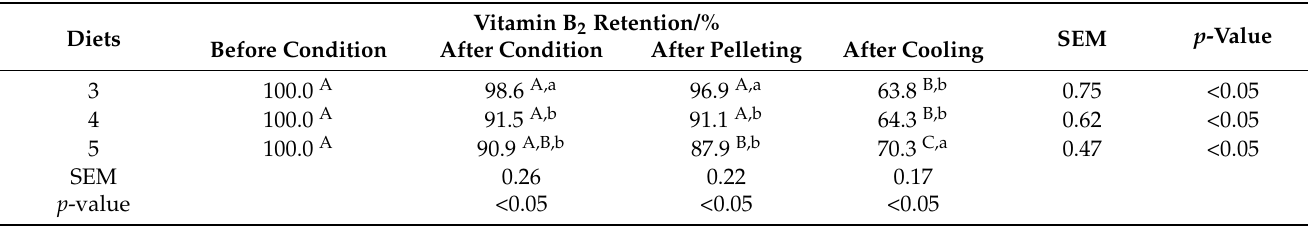
Table 6. The retention of vitamin B 2 in diets during pelleting and the long-term high-temperature stabilization process.